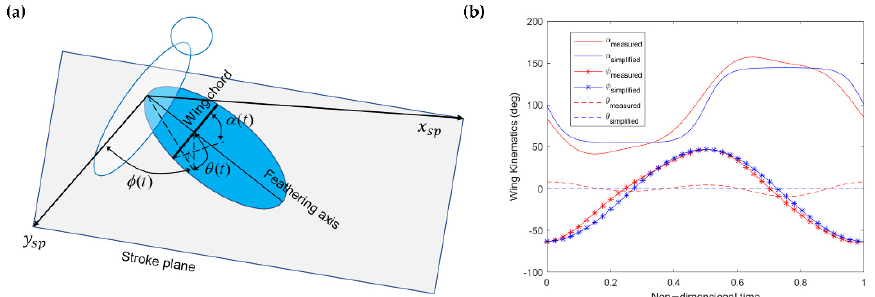
Figure 2. ( a ) Wing kinematics definition; ( b ) comparison between hawkmoth’s measurements from Willmott and Ellington [62] and simplified wing kinematics.